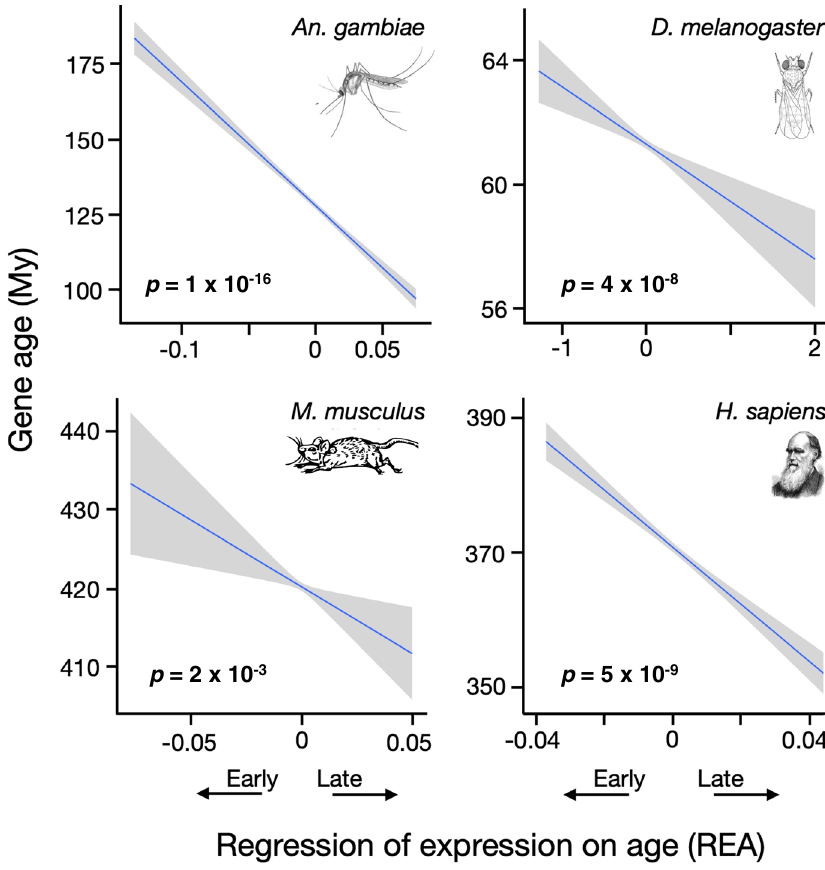
Fig. 3 Late genes are younger. Genes expressed later in life originated signi fi cantly more recently than those expressed early in all four species. Signi fi cance was determined by Spearman rank correlations, and p -values in bold are signi fi cant at p < 0.05 (two-sided tests, not corrected for multiple tests). The lines are least squares regressions, and the gray regions show the approximate 95% con fi dence intervals for the regressions. See also Supplementary Fig. 3 and Supplementary Table 1.